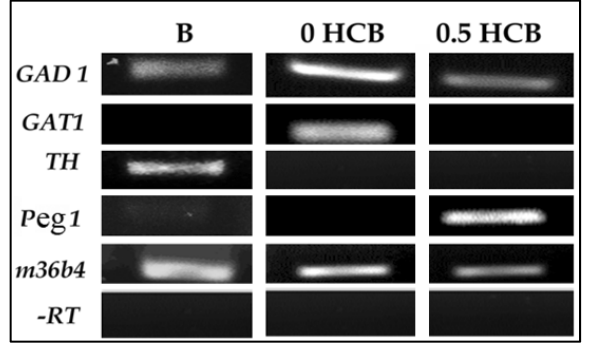
Figure 2. mRNA expression of cell lineage markers in differentiated ES cells treated with HCB. Encapsulated ES cells were treated with 0.5 nM HCB in the presence of RA (5 mM) for 4 days. Total RNA extracted at day 8 after encapsulation was reverse transcribed and used as template for PCR using specific primer pairs for the following markers: GAD1 (GABAergic neurons), GAT1 (astrocytes and neurons), TH (dopaminergic neurons), Peg1 (mesodermal marker), and 36B4 (a ubiquitously-expressed gene used as a loading control). –RT, no reverse transcriptase. B, adult mouse brain tissue (positive control). These experiments were performed a minimum of three times starting with cultured